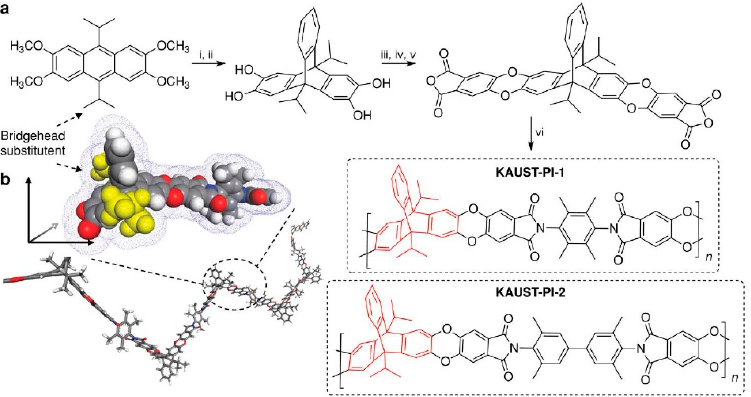
H 2 /CH 4 , and CO 2 /CH 4 (Figure 7). These membranes have also been used to define the 2015 upper bound limits for the separation of O 2 /N 2 due to its high separation performance [36].